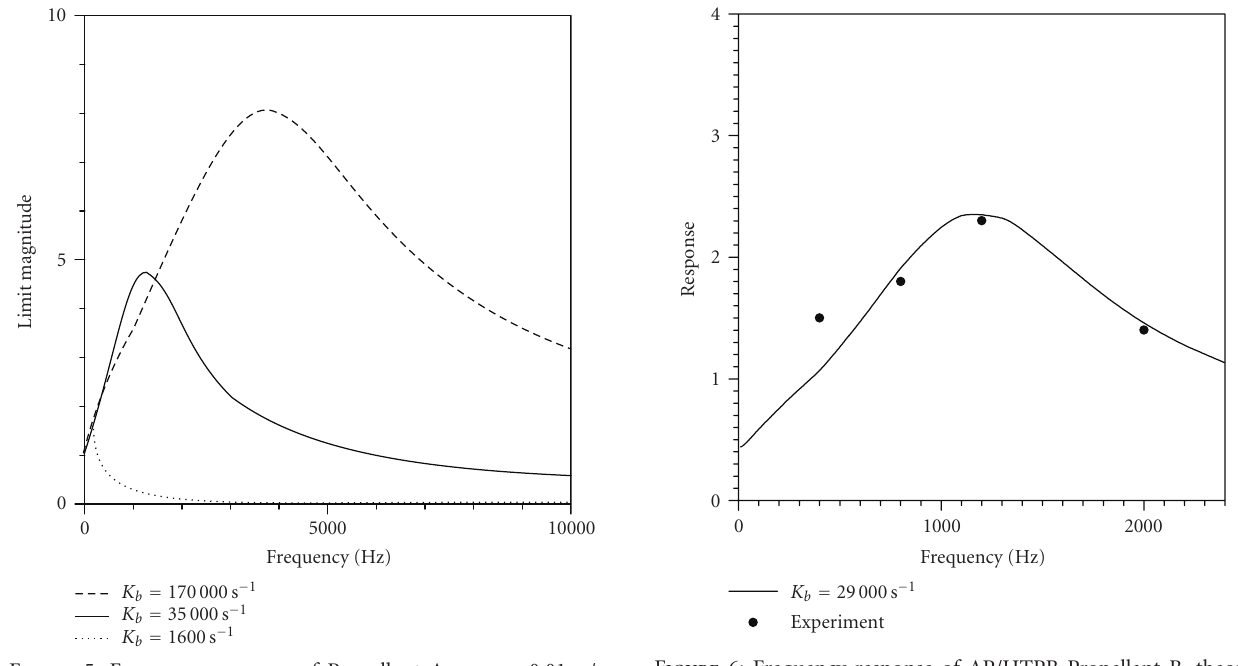
Figure 5: Frequency response of Propellant A, r b , o = 0.01m/s, Δ H s = 0.0J/kg.